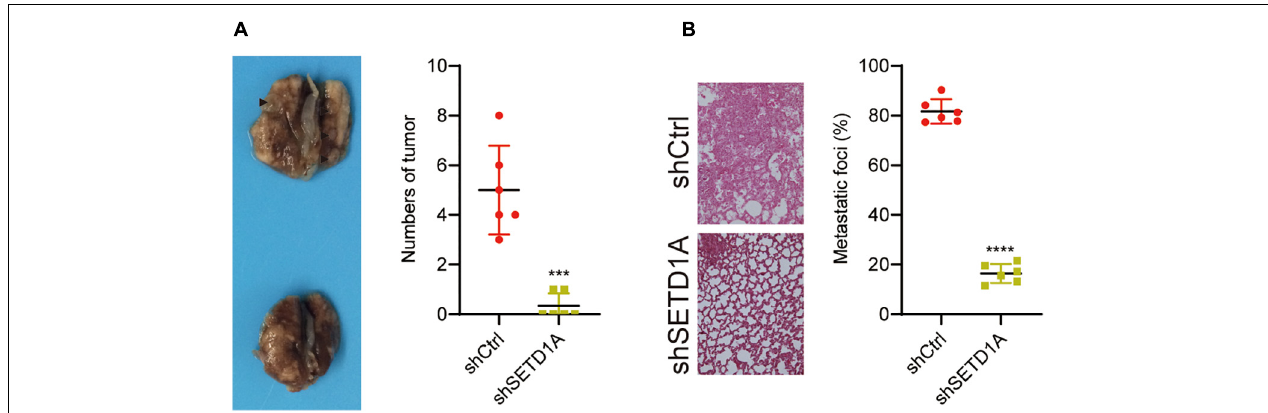
FIGURE 6 | Knockdown of SETD1A reduces GC cell metastasis. (A) Downregulation of SETD1A in BGC-823 cells reduces the number of tumors in the lung surface. Data from six mice are shown as the means ± SD. *** p < 0.001. (B) Downregulation of SETD1A in BGC-823 cells reduces tumor growth in the lung. Data from six mice are shown as the means ± SD. **** p < 0.0001 by Student’s t -test.